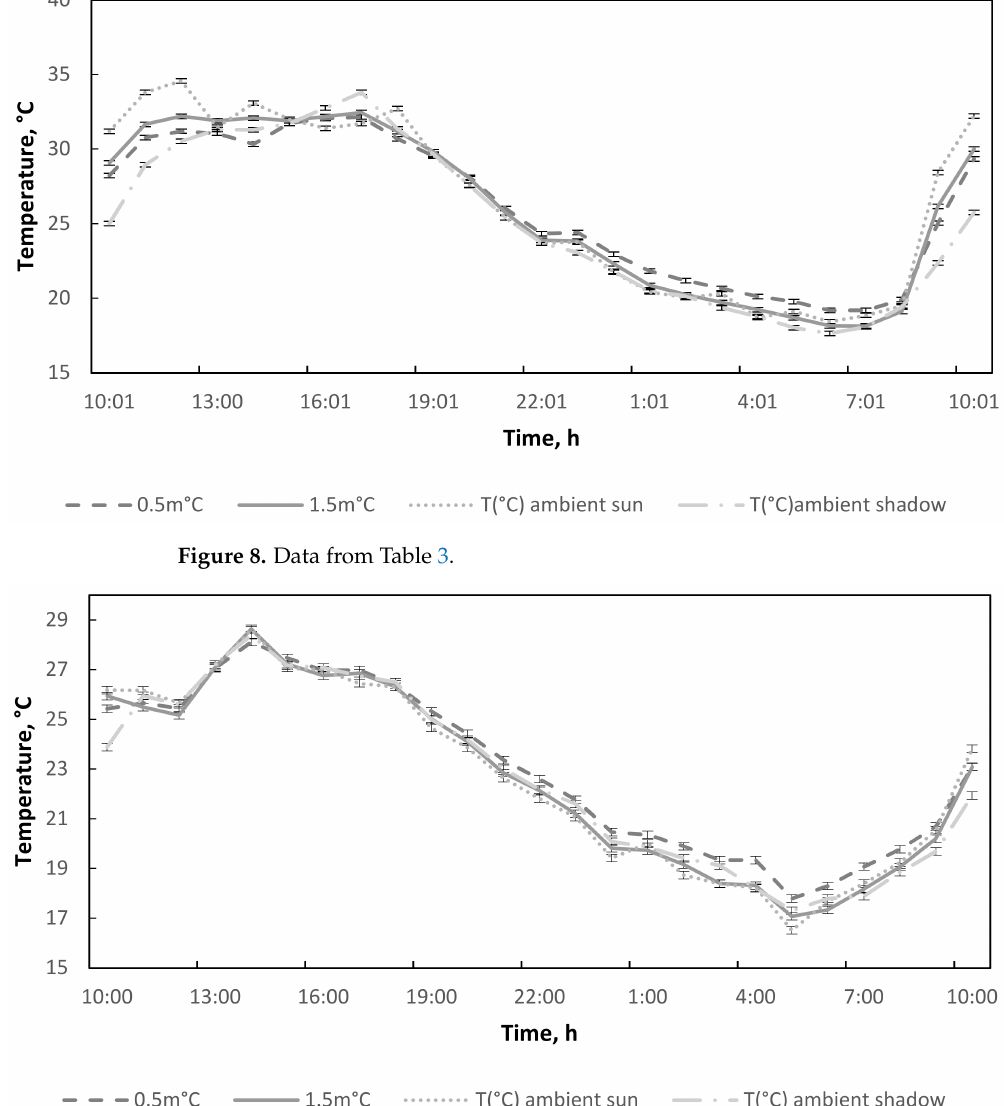
Figure 9. Data from Table